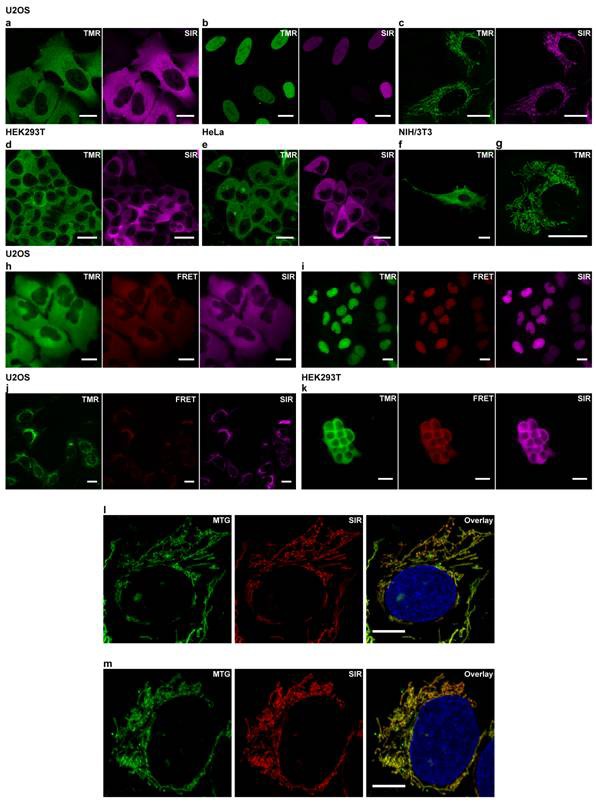
Live-cell imaging with NAD(P)-Snifit.Multichannel fluorescence confocal images of NAD(P)-Snifit localized in the cytosol (a), nuclei (b) and mitochondria (c) of U2OS cells. Confocal images of cytosolic NAD(P)-Snifit in HEK293T (d), HeLa (e) and NIH/3T3 (f) cells. (g) Confocal images of NADP-Snifit localized in the mitochondria of NIH/3T3 cells. Widefield images of NAD(P)-Snifit localized in the cytosol (h), nuclei (i) and the mitochondria (j) of U2OS cells and in the cytosol of HEK293T cells (k). All images were taken in full growth medium (DMEM +10% FBS). The different detection channels are represented using pseudocolors: donor channel (TMR, green), FRET channel (red) and the emission of acceptor through direct excitation (SiR, magenta). All images were subject to background correction and the FRET channel was additionally corrected for crosstalk. Scale bars, 20 µm. (l–m) Colocalization of mitochondrial NADP-Snifit with MitoTracker Green. Three color confocal images of MitoTracker Green (MTG, green), mitochondrial localized NADP-Snifit (red) using the acceptor dye channel (SiR) and Hoechst 33342 as nuclear stain (blue) in living U2OS cells. The images were deconvolved using Huygens Essentials package prior to the colocalization analysis. The Pearson’s coefficient between the MTG and SiR channels are 0.80 (l) and 0.90 (m). Scale bars, 10 µm.